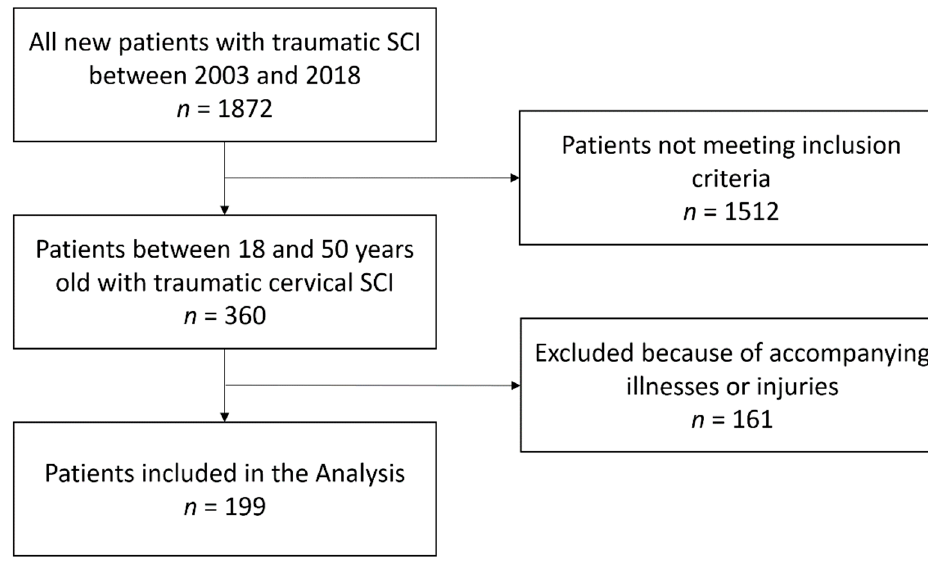
Figure 1. Inclusion and exclusion criteria before analysis. SCI = Spinal Cord Injury.